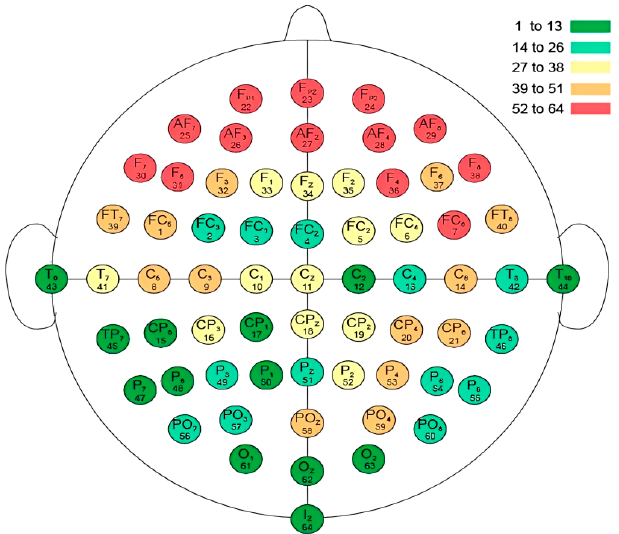
Figure 8. The Relationship between Brain Regions and Person Identification. Table 5 identifies channel 64 as the best channel for identification in all three cases, which is consistent with the findings of Suppiah and Vinod in [13]. The electrode of channel 64 is placed on the inion bump, which is known as the internal occipital protuberance. These experiments also reveal that merging the protocols outperforms separate